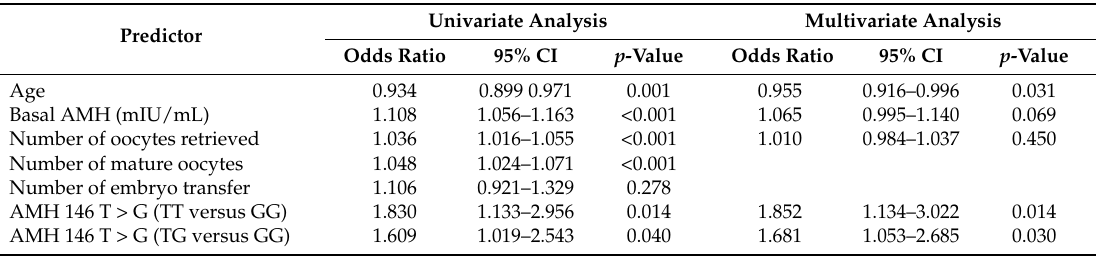
Table 7. Univariate and multivariate logistic regression analysis of different variables to predict clinical pregnancy after IVF